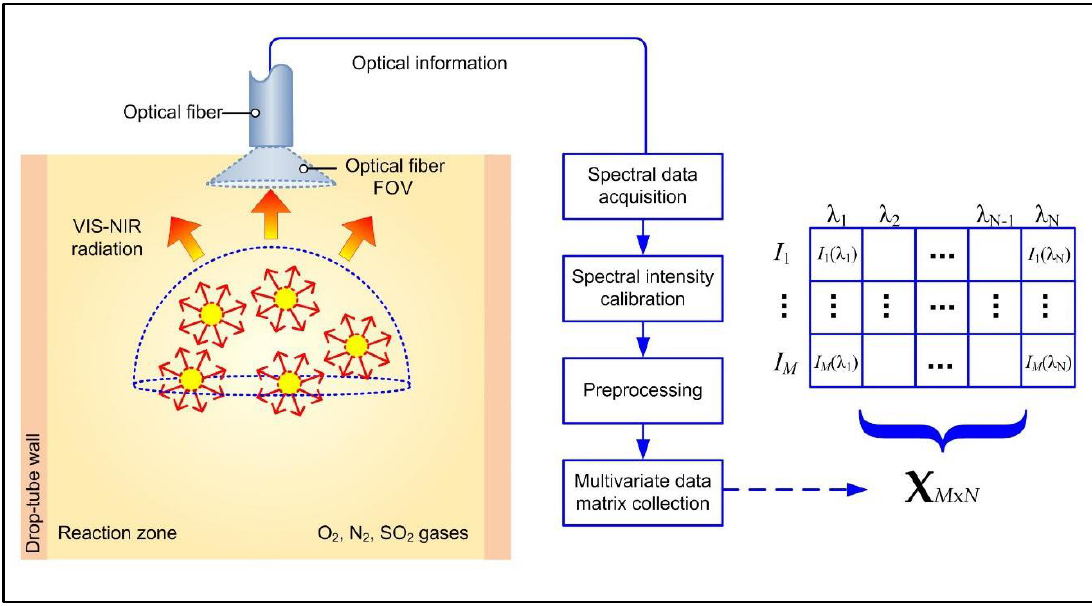
Figure 2. General spectral data acquisition and preprocessing pipeline.